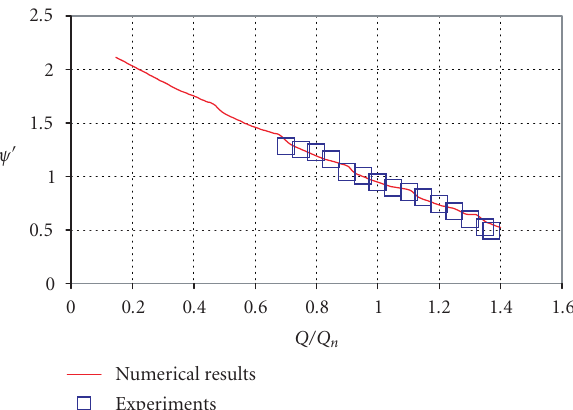
( Q/Q n ) of the inducer in noncavitating s